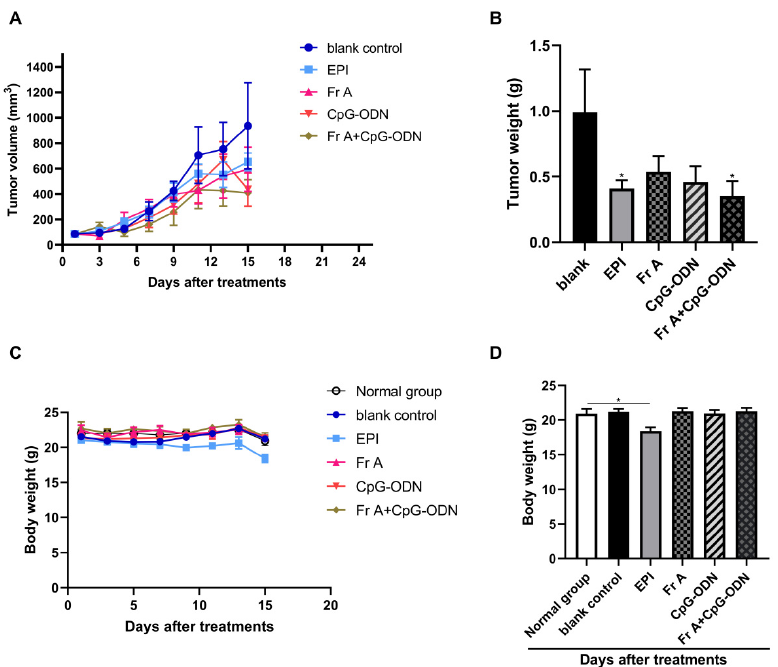
Figure 7. The suppression on the tumor growth of human bladder cancer xenografts. Bladder cancer cells UM-UC-3 (3 million per mouse) were subcutaneously transplanted into immune-deficient